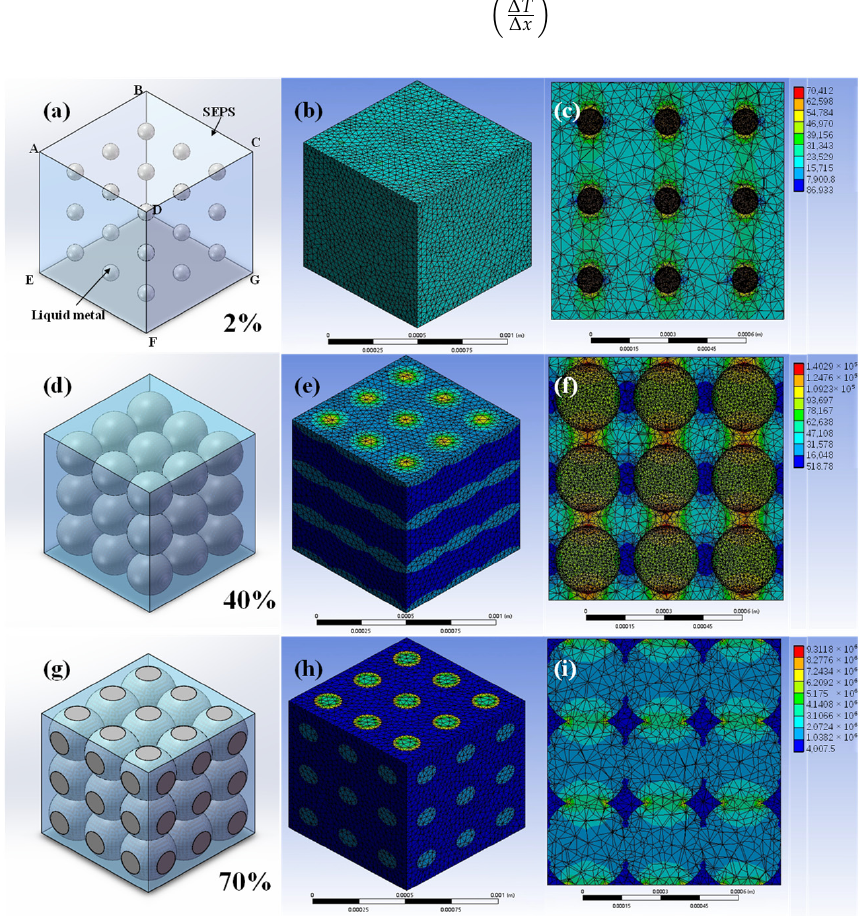
Figure 4. ( a , d , g ) Geometric models of composites with different liquid metal proportions(2%, 40%, and 70%). ( b , e , h ) finite element analysis on heat flux diagram of the B-LM-ECF with different liquid metal proportions. ( c , f , i ) cross-section heat flux diagram for finite element analysis on the B-LM-ECF with different liquid metal